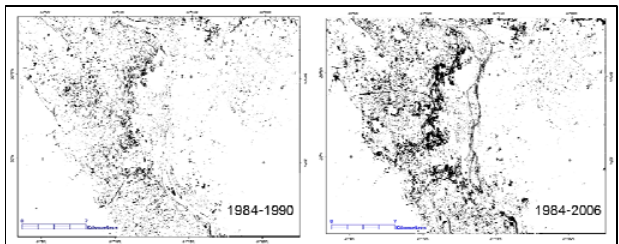
Figure 5. The classes of informal urbanization in the study area according to the textural density and shape Objects are described by their specific spectral information, shape, and texture. The brightness relationship of adjacent image objects was worked out explicitly. For that purpose, the relationships between objects were established. Based on the objects and the class descriptions, a fuzzy